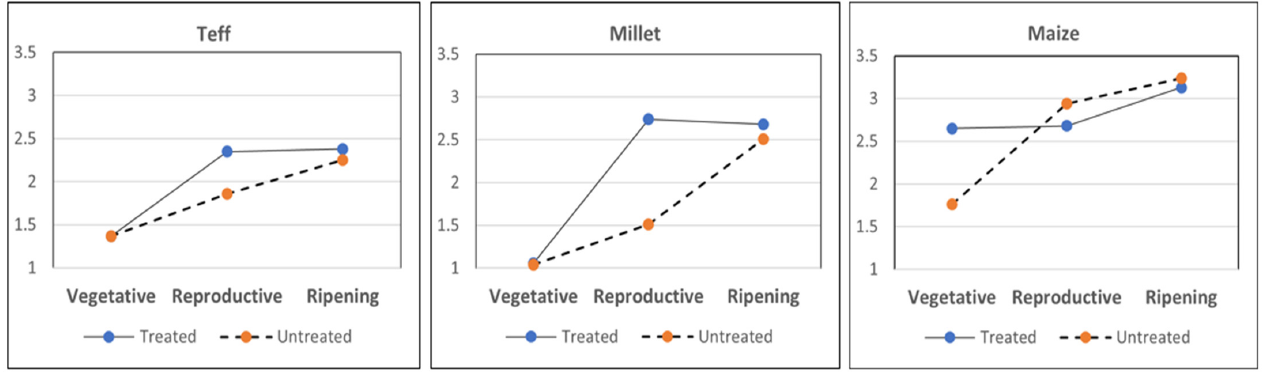
Figure 5. Leaf area index (LAI) of teff, millet and maize across growth stages in the SWC treated and untreated watersheds.